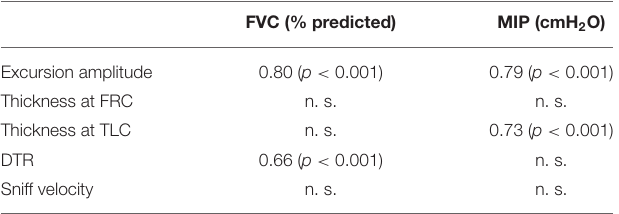
TABLE 2 | Correlation analysis between diaphragm ultrasound parameters and bedside tests of respiratory muscle function.